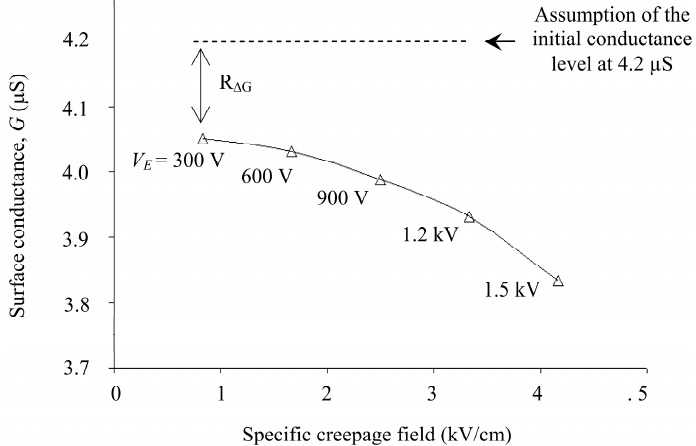
Figure 10. Surface conductance as a function of specific electric field on polluted insulator energized with different voltage levels.